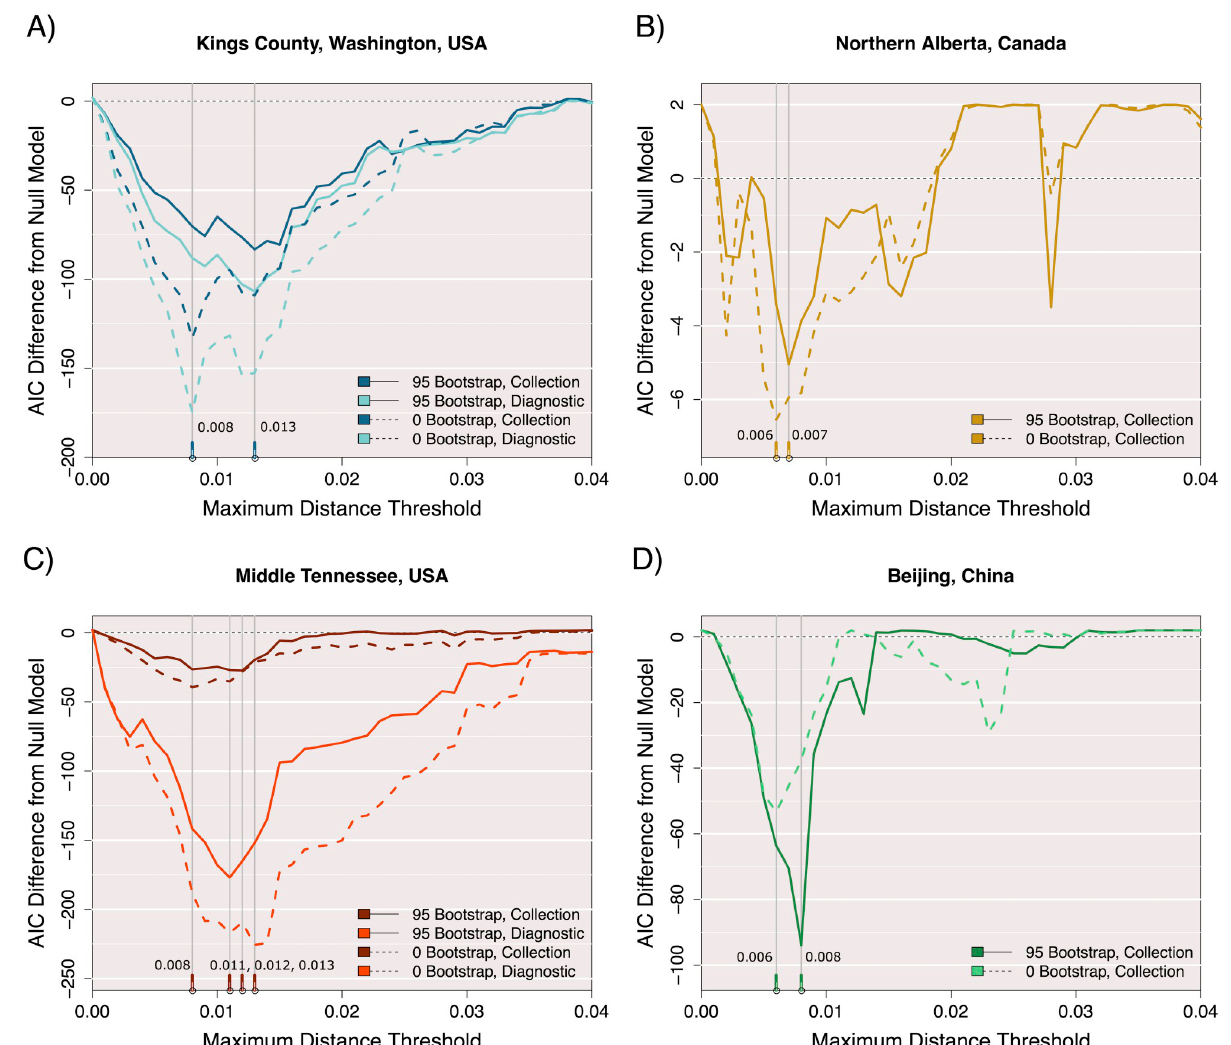
Fig 4. Effect of bootstrap thresholds on Δ AIC profiles. The AIC difference between two Poisson-linked models of cluster growth for all four full data sets, with clusters and growth defined at 41 different maximum distance thresholds from 0 to 0.04. The AIC of a null model where size predicts growth is subtracted from the AIC of a proposed model where size and time predict growth. For the data sets where either sequence collection date or associated patient diagnostic date could define time, both AIC difference results are shown by separate colours. Solid lines represent AIC differences obtained using an additional bootstrap threshold of 0.95 to define clusters and growth, while dashed lines were obtained without this